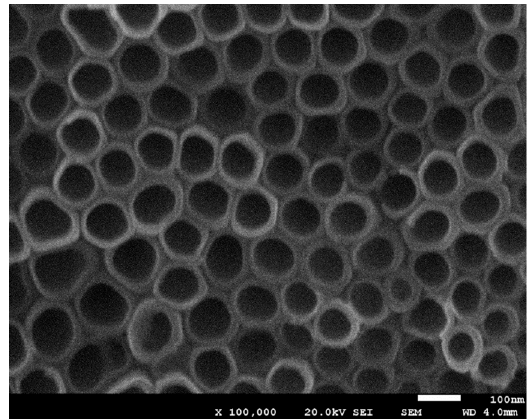
Figure 2. FE-SEM image of the formed TiO 2 nanotube arrays.